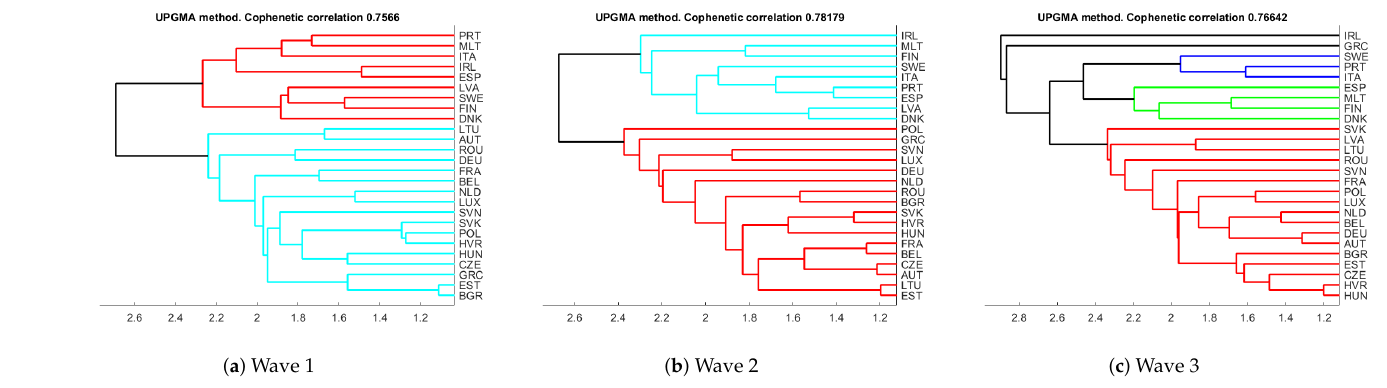
Figure 9. Visualization step: Hierarchical clustering for waves